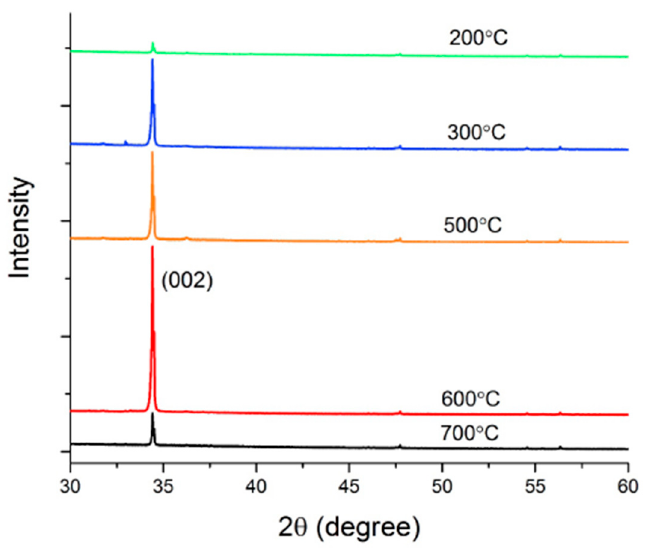
Figure 3. XRD spectra of ZnO NRs grown on SLs pre-annealed at different temperatures.